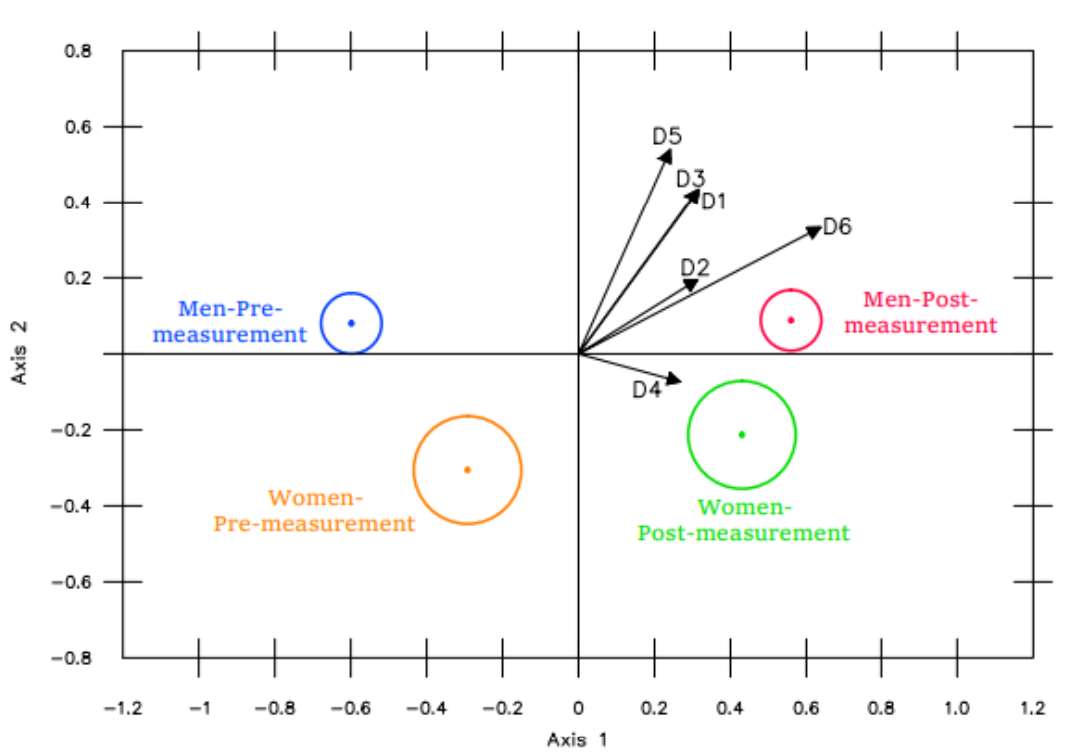
Figure 5. Men/Women + Pre-/Post-measurement.